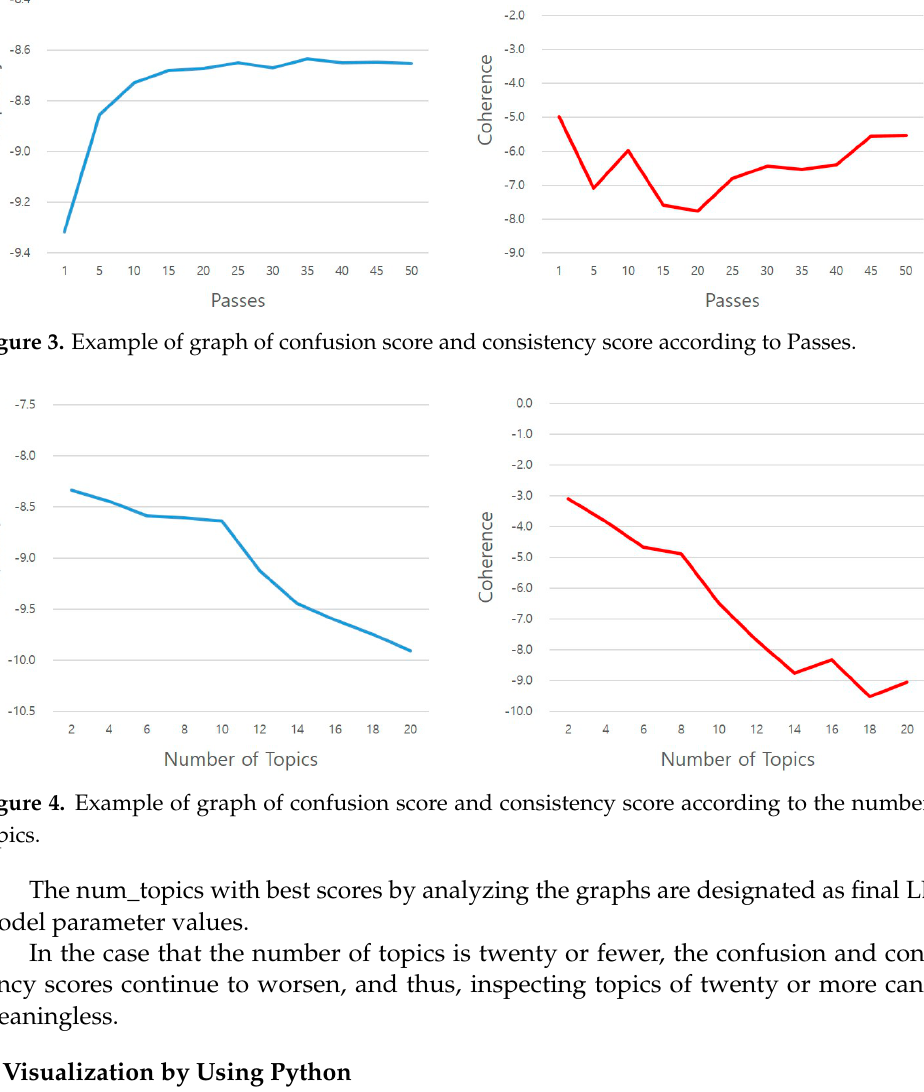
Figure 3. Example of graph of confusion score and consistency score according to Passes.